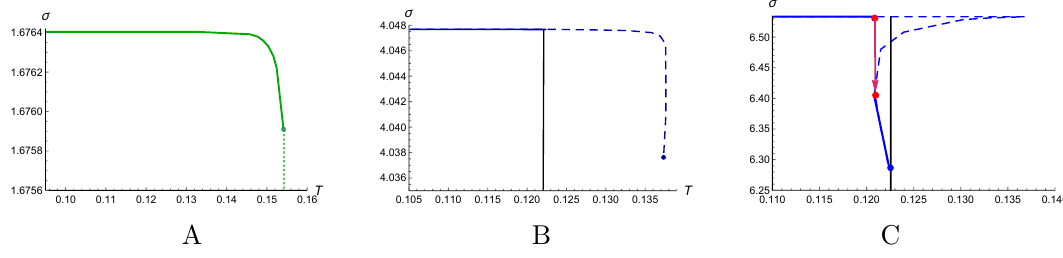
Figure 18 . String tension as function of temperature for z 0 = 0 , µ = 0 , ν = 1 (A) and z 0 = 0 . 1 , µ = 0 , ν = 4 . 5 , longitudinal (B) and transversal (C); a = 4 . 046 , b = 0 . 01613 , c = 0 . 227 . Solid lines — the realized values of string tension; dotted green line (A) — the WL phase transition; black solid lines (B,C) — BH-BH phase transition; dashed blue lines — string tension for temperature higher than the temperature of BH-BH phase transition, T > T BH − BH . In the transversal (C) case the string tension is three-valued function and the string tension has phase transition that happens for less temperatures than the temperature of BH-BH phase transition. Red arrow shows jumps of the string tension.